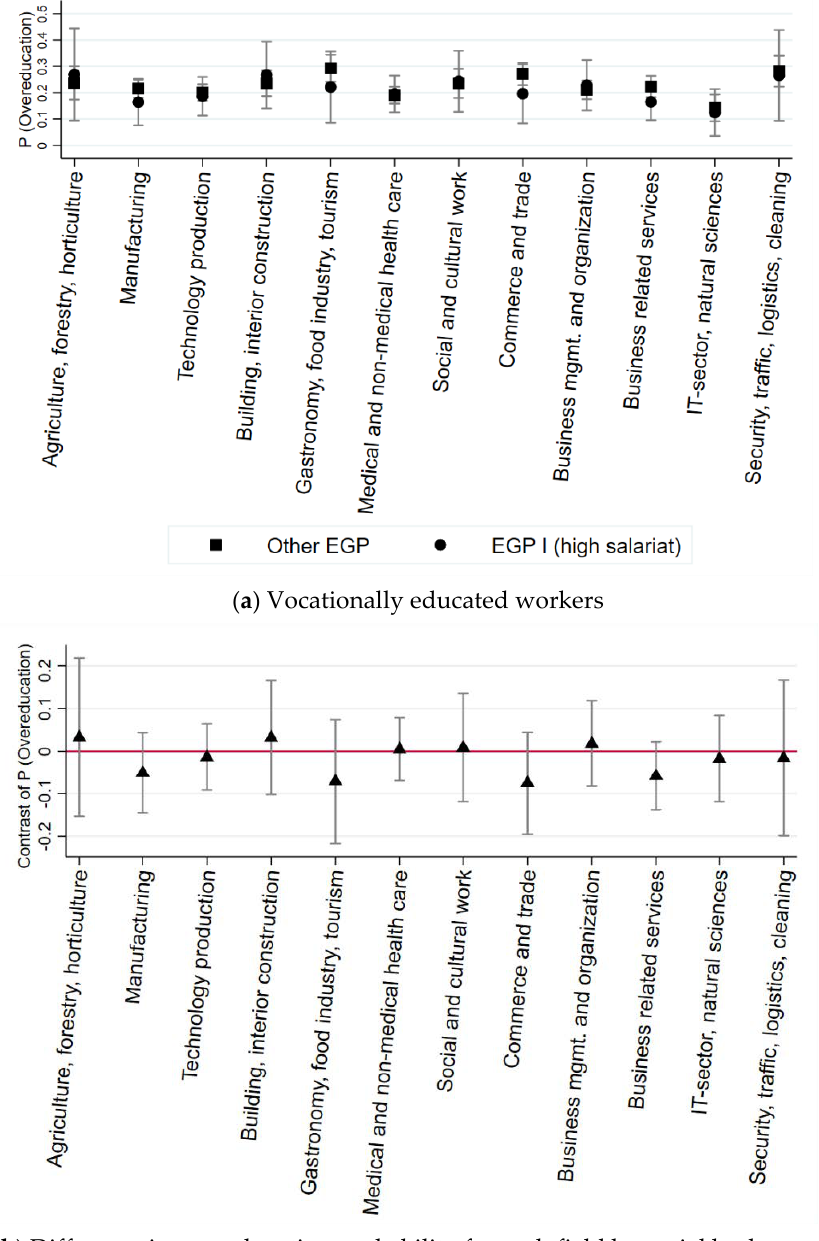
Figure 3. ( a ) Predicted probability of overeducation (subjective indicator) (AME) within vocationally educated workforce for each combination of educational field and social background; ( b ) social background differences (EGP I high salariat-other EGP) of predicted probability of overeducation for each educational field. Confidence intervals at 95-percent level. Weighted results. Data: BIBB/BAuA Employment Survey 2018, authors’ own calculations.